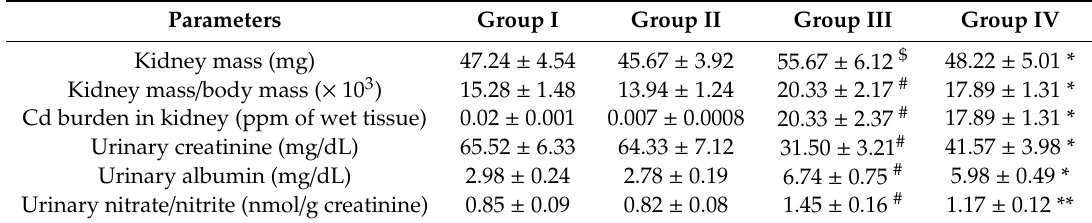
Table 2. The e ff ects on kidney mass, Cd accumulation, and renal function related to urine